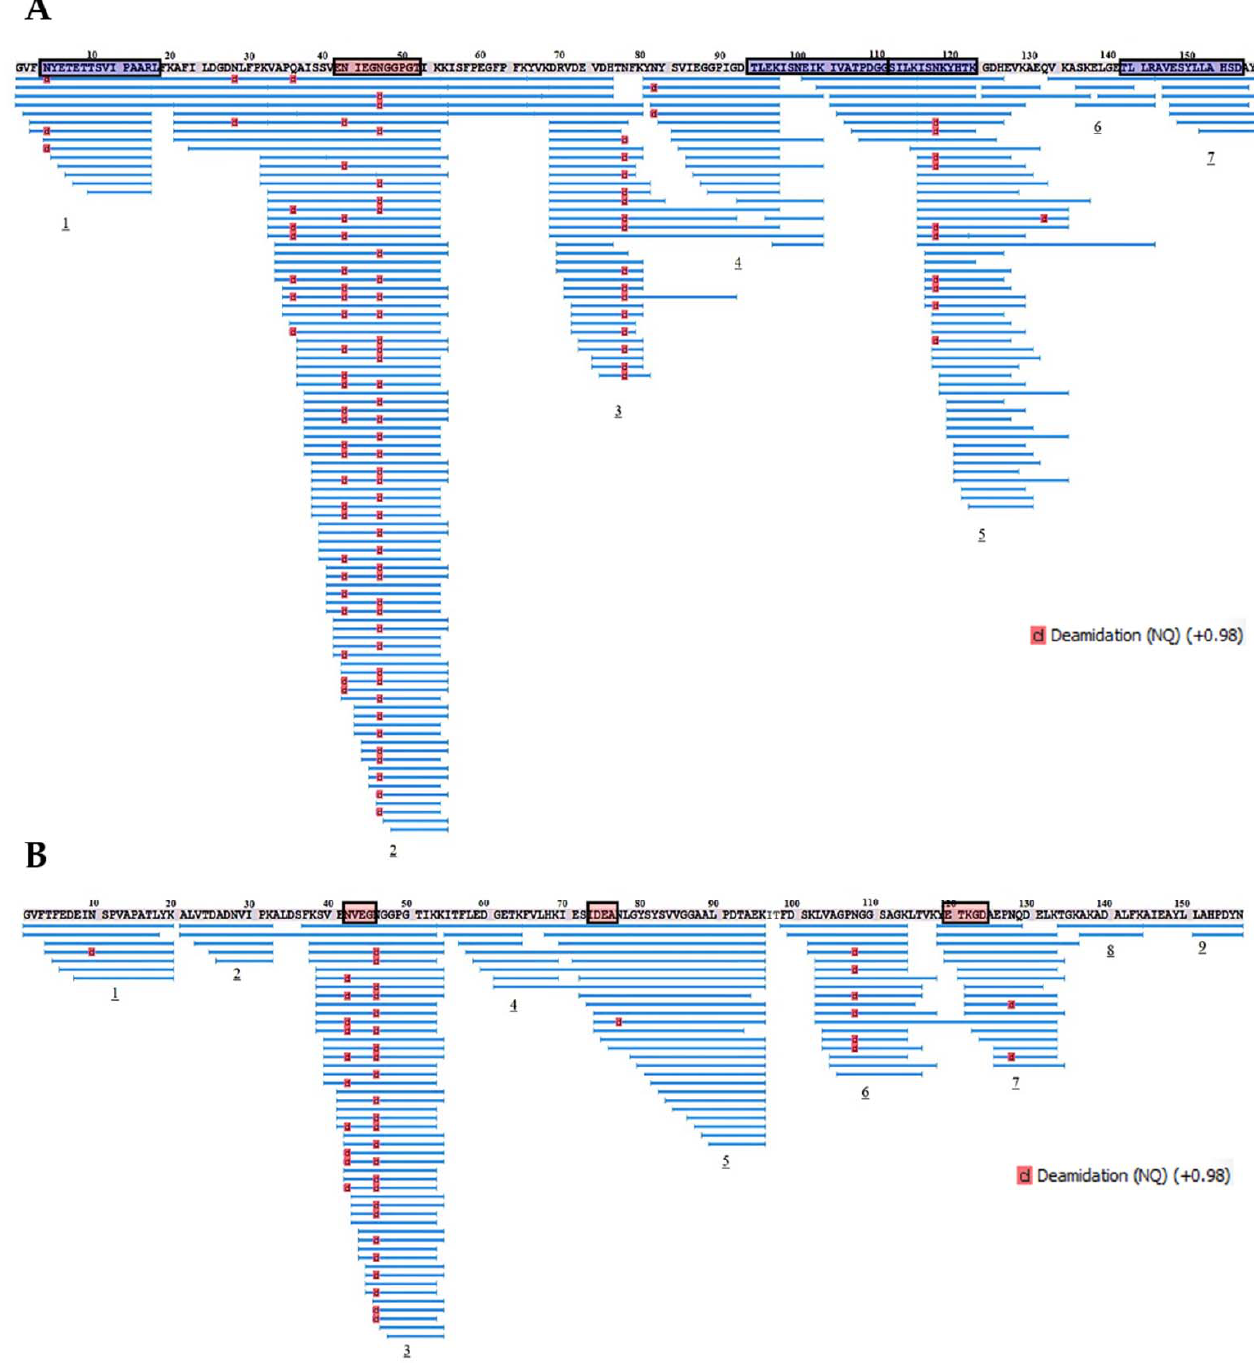
Figure 9. The fragments of Bet v 1 ( A ) and Gly m 4 ( B ) resulted from allergens degradation in vitro by lysosomal enzymes of human macrophages for 24 h. Numbers 1–9 show the main clusters of peptide fragments of the investigated birch and soybean allergens. Dominant IgE-binding linear epitopes of Bet v 1 [29] and Gly m 4 [23] are framed in red. Dominant T-cell epitopes of Bet v 1 [28] are framed in blue.